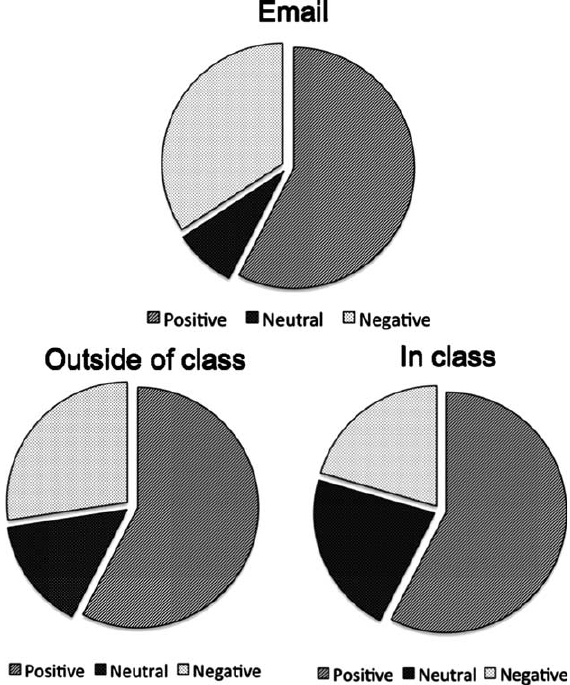
Figure 4. How staff are contacted by student to provide feedback